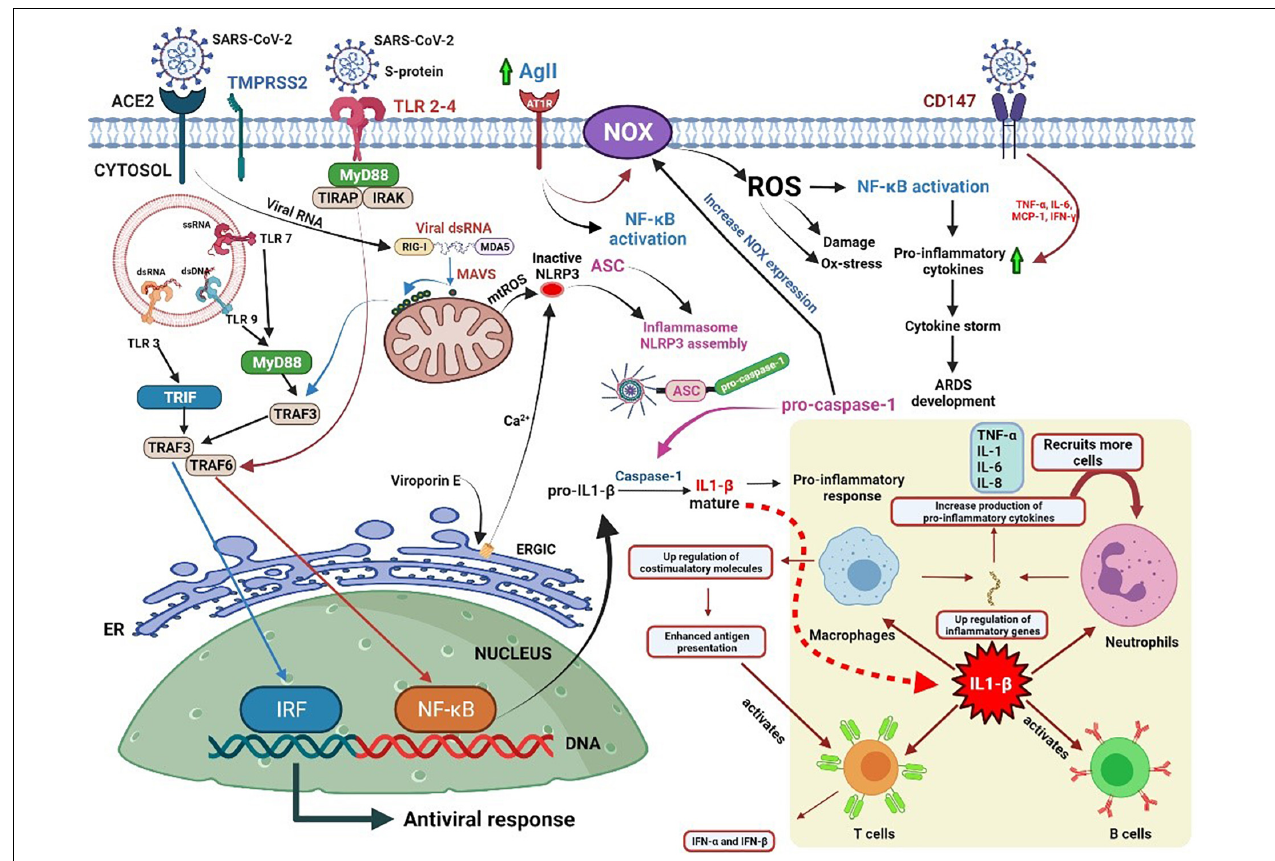
FIGURE 1 | Potential pathways of oxidative stress and the role of IL-1 β in eliciting immune responses against coronavirus